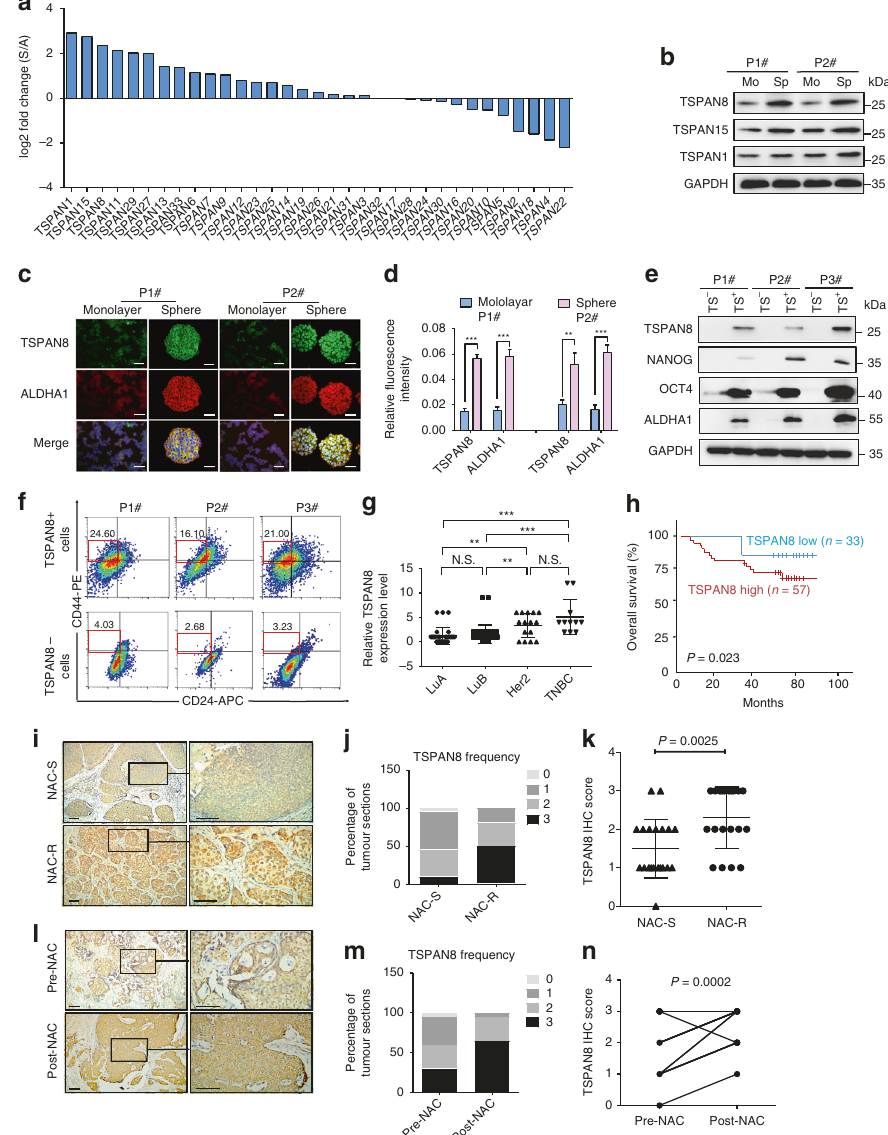
Fig. 1 TSPAN8 expression is upregulated in breast CSCs. a Microarray analyses of expression of 33 members of tetraspanins family expressed in CSCs (spheres) or their corresponding non-CSCs (adherent cells) derived from three independent breast cancer patients. b Freshly isolated primary human tissues derived from two independent breast cancer patients were grown as adherent cells or spheres. Immunoblotting analyses of TSPAN8, TSPAN15 and TSPAN1 were performed. c Representative confocal images for TSPAN8 (green), ALDHA1 (red), and nuclei (blue) of adherent cells or spheres from two breast cancer patients were shown. d Quanti fi cation of the relative fl uorescence intensity of TSPAN8 and ALDHA1 in spheres or adherent cells. Two-tailed Student ’ s t test was used for statistical analysis. *** P < 0.001, ** P < 0.01, * P < 0.05. e Immunoblotting analyses of TSPAN8, NANOG, OCT4, and ALDHA1 expression in breast cancer cells from three patients were performed. TS − : TSPAN8-negative breast cancer cells, TS + : TSPAN8-positive breast cancer cells. f Flow cytometry analysis of the ratios of CD44 + /CD24 − cells in TS + breast cancer cells or TS − breast cancer cells derived from three human breast cancer patients. g Semi-quantitative analyses of IHC staining of TSPAN8 in tissue sections of 90 breast cancer patients with different pathological molecular subtypes. *** P < 0.001, ** P < 0.01, * P < 0.05 and N.S., not signi fi cant ( P > 0.05) by repeated measures with Student ’ s t test. LuA = luminal A subtype, LuB = luminal B subtype, Her2 = Her2 ampli fi ed subtype, TNCB = triple-negative subtype. h Kaplan – Meier of survival of 90 patients with breast tumors (two groups strati fi ed by TSPAN8 expression level. Differences between the groups were shown by a log-rank test. i – k Immunohistochemistry analyses of TSPAN8 expression in specimens of breast cancer patients with NAC-S (neo-adjuvant chemotherapy sensitive) and NAC-R (neo-adjuvant chemotherapy resistant) characteristics (scale bar = 50 μ m, n = 20). l – n Immunohistochemistry analyses of TSPAN8 expression in specimens of breast cancer patients with Pre-NAC (before neo-adjuvant chemotherapy) and Post-NAC (after neo-adjuvant chemotherapy) (scale bar = 50 μ m, n = 20). Note that some dots